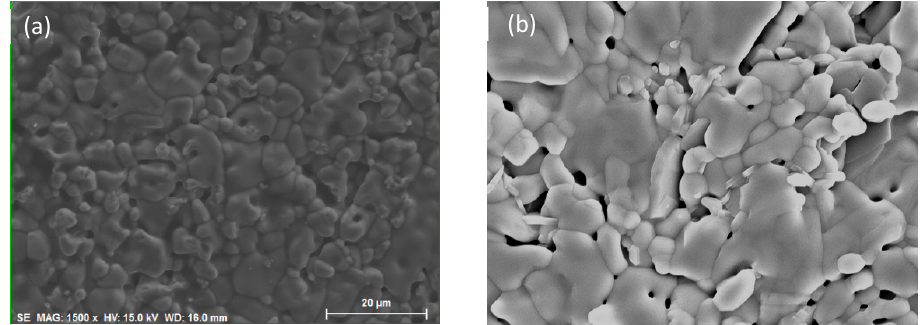
Figure 2. Scanning election microscopy (SEM) images of AlFe 0.95 Cr 0.05 O 3 ( a ) prepared by solid state Figure 2. SEMimagesofAlFe 0.95 Cr 0.05 O 3 ( a )preparedbysolidstatereaction( b reaction ( b ) prepared by coprecipitation.